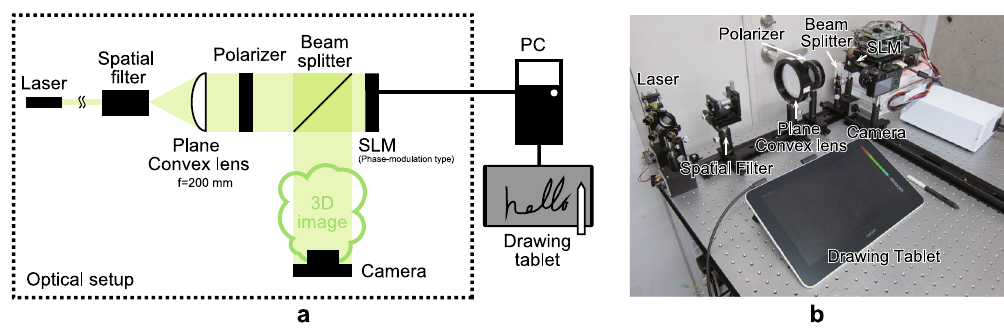
Figure 2. Optical setup of the proposed system. ( a ) Schematic illustration of the proposed system. ( b ) Optical setup of the proposed